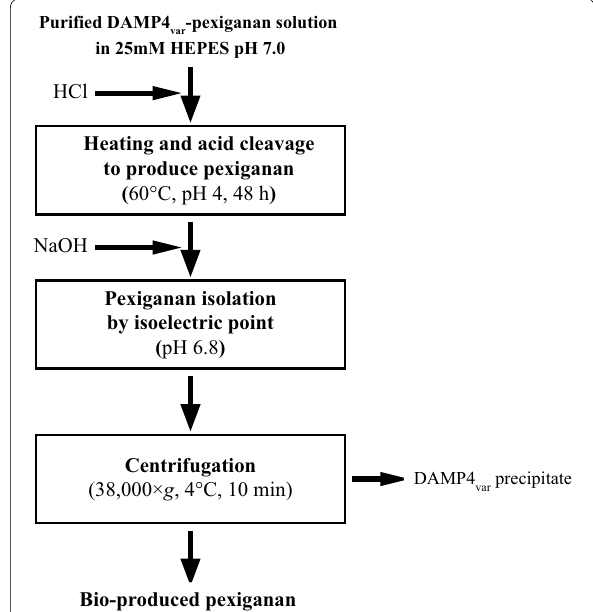
Fig. 6 Process flow diagram of the cleavage of pexiganan peptide from the protein carrier DAMP4 var